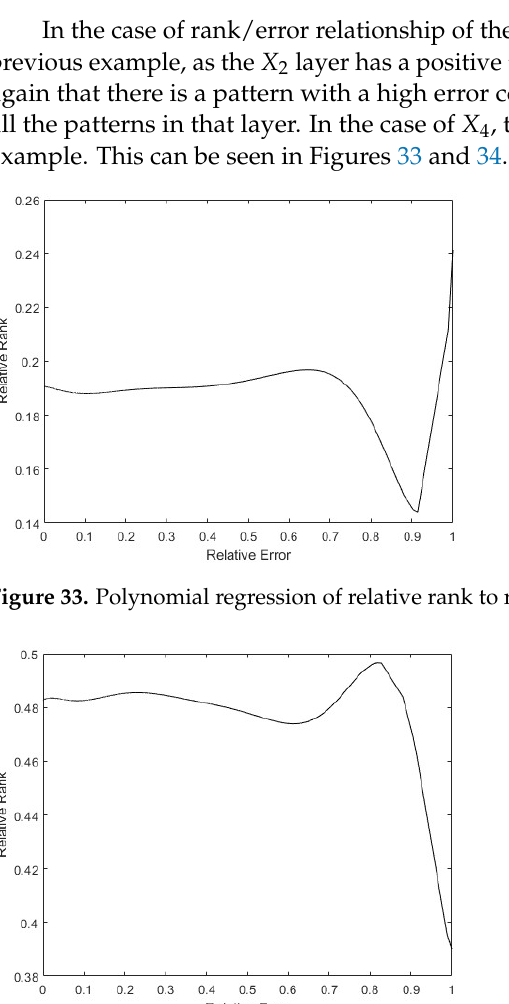
(cid:12) (cid:12) on the right. ∂ W n (cid:3105)(cid:3024) (cid:3289)